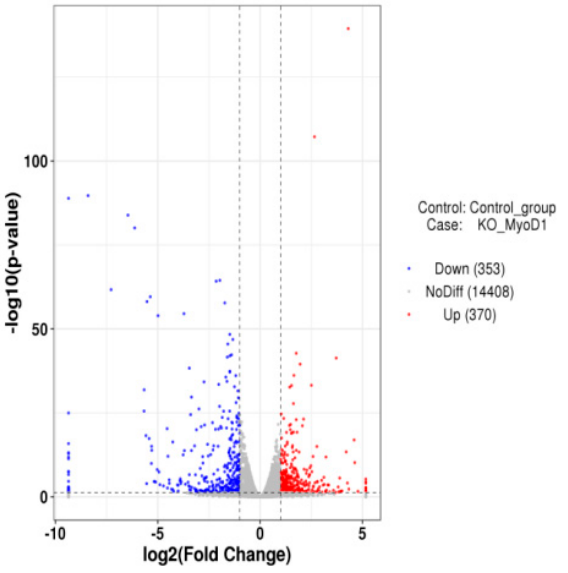
Figure 4. DEGs generated from a comparison of MDBK wild type and MyoD1 knockout cells. Red,